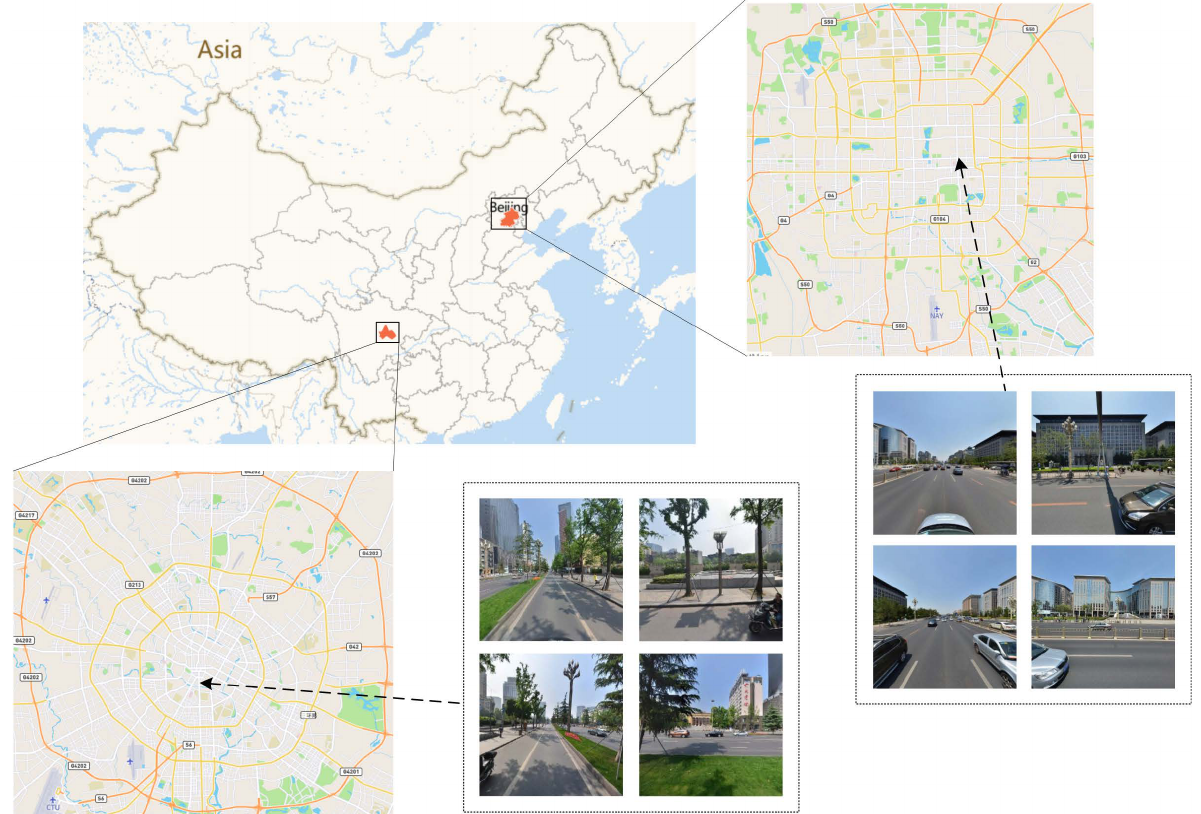
Figure 1. Street view image samples of the case study